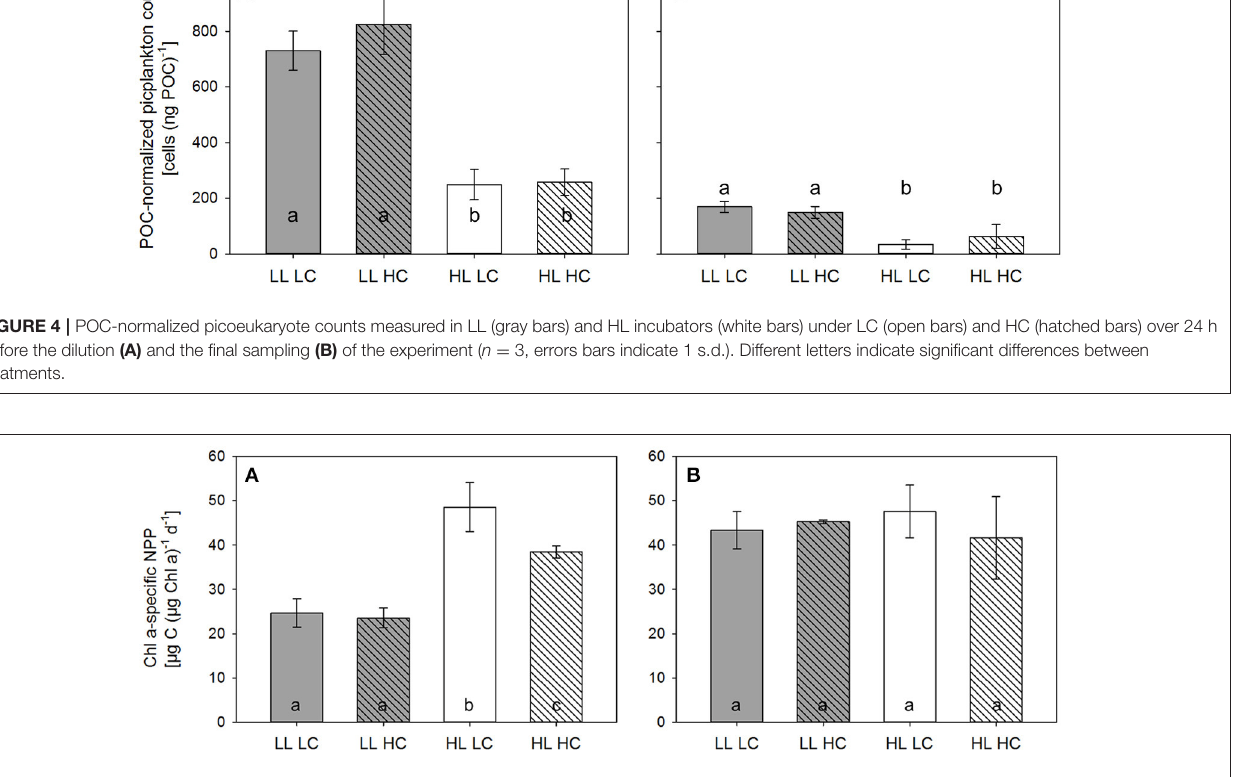
FIGURE 5 | Chl a -specific net primary production (NPP) measured in LL (gray bars) and HL incubators (white bars) under LC (open bars) and HC (hatched bars) over 24 h directly before the dilution (A) and the final sampling (B) of the experiment ( n = 3, errors bars indicate 1 s.d.). Different letters indicate significant differences between